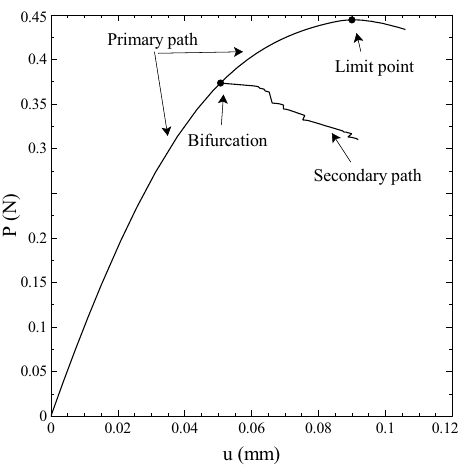
Figure 13. Bifurcation plot of the arch subjected to distributed pressure.